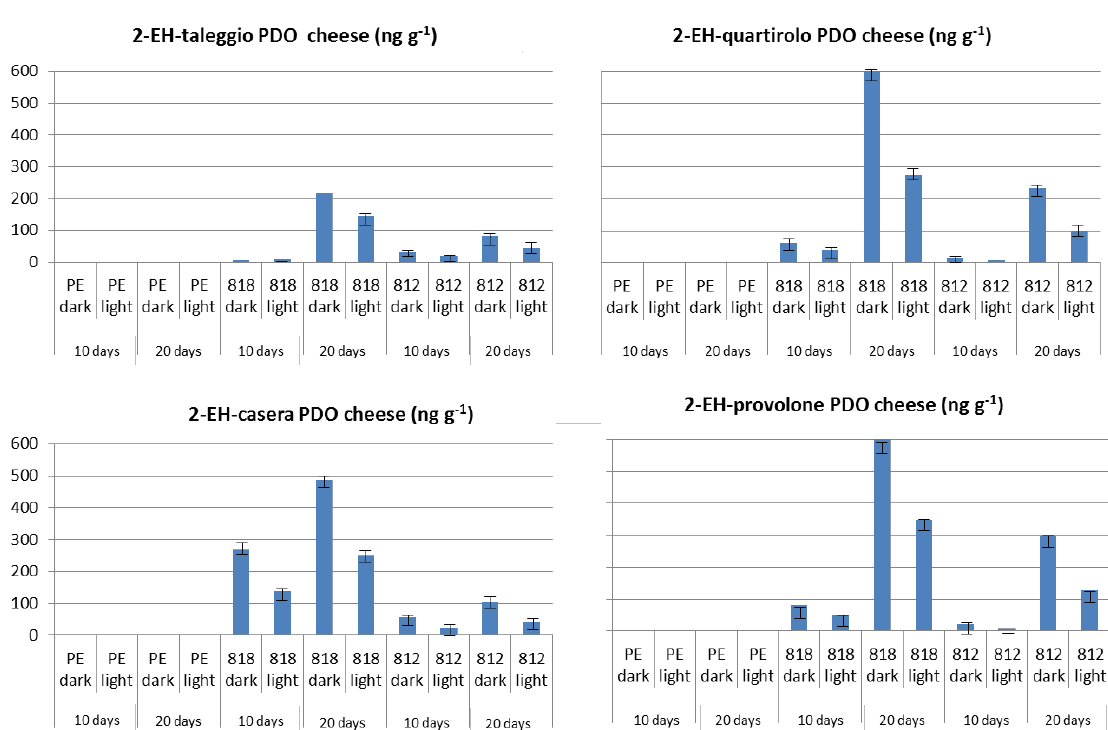
Figure 5. Levels of 2-ethylhexanol (2-EH) in PDO cheeses wrapped in different cling-films and stored refrigerated for 10 and 20 days in the dark or under fluorescent light (data expressed as ng·g −1 of